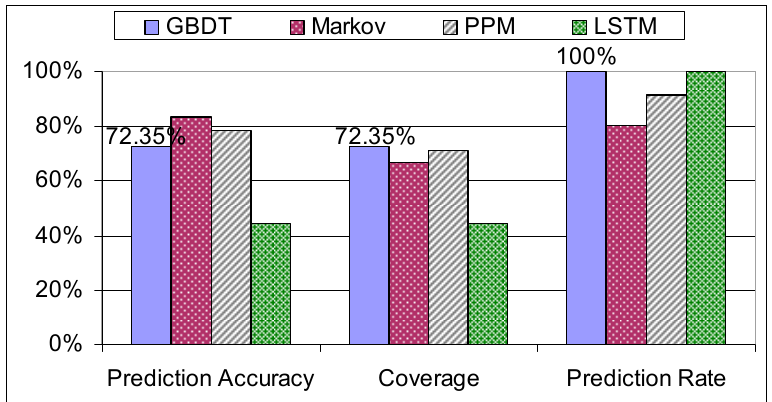
Figure 15. Comparison on the “Workers” dataset.